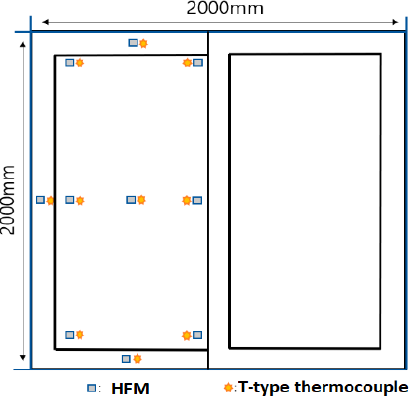
Figure 6. Illustration of the measurement points for in situ HFM method. Reproduced from Park et al. [11].